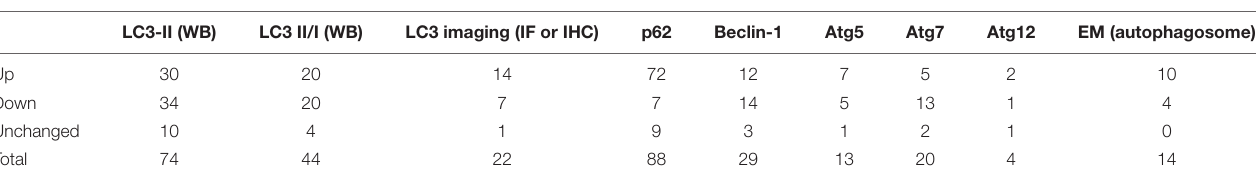
FIGURE 3 | Overview of autophagy pathways in mammalian cells. Common autophagy markers and their participation in autophagic machinery, as discussed in Section “Autophagy Markers.” Signaling pathways that culminate in autophagy induction commonly lead to the activation of ULK1 kinase complex, promoting its localization at autophagy initiation sites near the endoplasmic reticulum (ER). ULK1 complex activity regulates the activation of the class III phosphatidylinositol 3-kinase (PI3K) complex, consisting of class III PI3K, VPS34, and other interacting proteins, including BECLIN-1. This complex is responsible for the production of phosphatidylinositol 3-phosphate (PI3P) at the site of early isolation membrane formation, which is essential for the nucleation step in the autophagic pathway. PI3P acts as a signaling molecule that recruits the double FYVE containing protein 1 (DFCP1) and other PI3P-binding proteins that promote the omegasome formation. At the expansion step, the autophagy-related protein 7 (ATG7) functions as an E1-like enzyme that catalyzes the conjugation of ATG12 to ATG5 in collaboration with the E2-like activity of ATG10. ATG12-ATG5 interacts with ATG16L at the vesicle membrane, marking the lipidation site. Microtubule-associated proteins 1A/1B light chain (LC3) at its mature form (LC3-I) are conjugated to phosphatidylethanolamine (PE) through the combined activity of ATG7 (E1-like enzyme), ATG3 (E2-like enzyme) and ATG12-ATG5 (E3 ligase enzyme). LC3 conjugated to PE (named LC3-II) is located at the autophagosome membrane and is important for the expansion and completion of the isolation membrane. P62/sequestosome-1 (named p62) works as an autophagy adaptor that recognizes polyubiquitinated cargos that will be sequestered for autophagic degradation due to their interaction with LC3-II. P62 phosphorylation at serine 403 (p-S403) increases affinity for polyubiquitinated targets and is promoted during autophagy activation. P62 phosphorylation at serine 349 (p-S349) is important for its competitive interaction with KEAP1 protein, promoting the activation of the NRF2 transcription factor, important during non-alcoholic liver disease (NALFD) development. Other autophagy adaptors besides p62 may participate during cargo recognition of selective autophagy. After autophagosome closure, the autophagic pathway proceeds with the formation of the autolysosome. The autophagosome external membrane fuses with the lysosome, releasing lysosome acidic hydrolases into the autophagosome lumen, and promoting cargo digestion. Importantly, LC3-II and p62 present within the autolysosome are also degraded in this process. TABLE 8 | Autophagy